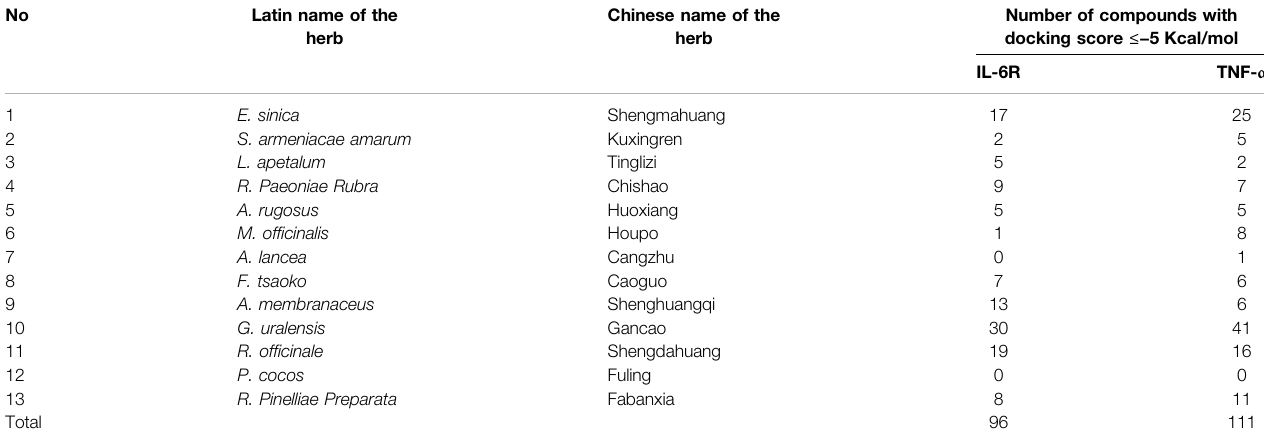
TABLE 2 | Number statistics of molecular docking.